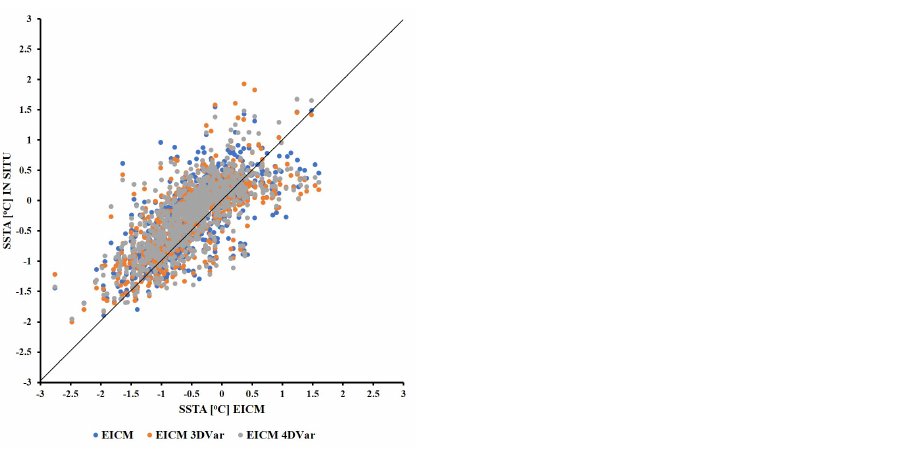
Figure 9. Correlation of the SSTA ( ◦ C) from the EICM and EICMDA with in-situ measurements. The performance of the model was achieved by comparing the SSTA data of the three simulations with the SSTA data from the buoy, with each data point being compared, as shown in Figure 8. The main statistical parameters were calculated separately for each month. It was found that, during the La Niña phenomenon from January to June, the EICMDA was more accurate than EICM without Data Assimilation. In the normal period, it was found that EICMDA and EICM can simulate very different SSTA values, whereby EICMDA with 4D-Var has a lower error than the EICMDA with 3D-Var and EICM simulation. The average RMSE of EICMDA with 4D-Var is 0.492, which is the smallest error when compared to other methods. When looking at the correlation between the model and the source data, it was found that the average correlation coefficient was 0.684, which means that the data from the model correlated with source data in the same way. The correlation coefficient from the three simulations gave little difference, as shown in Table 1. Table 1. Statistics of the EICM and EICMDA in comparison with in-situ measurements for each month separately. Month Measurements